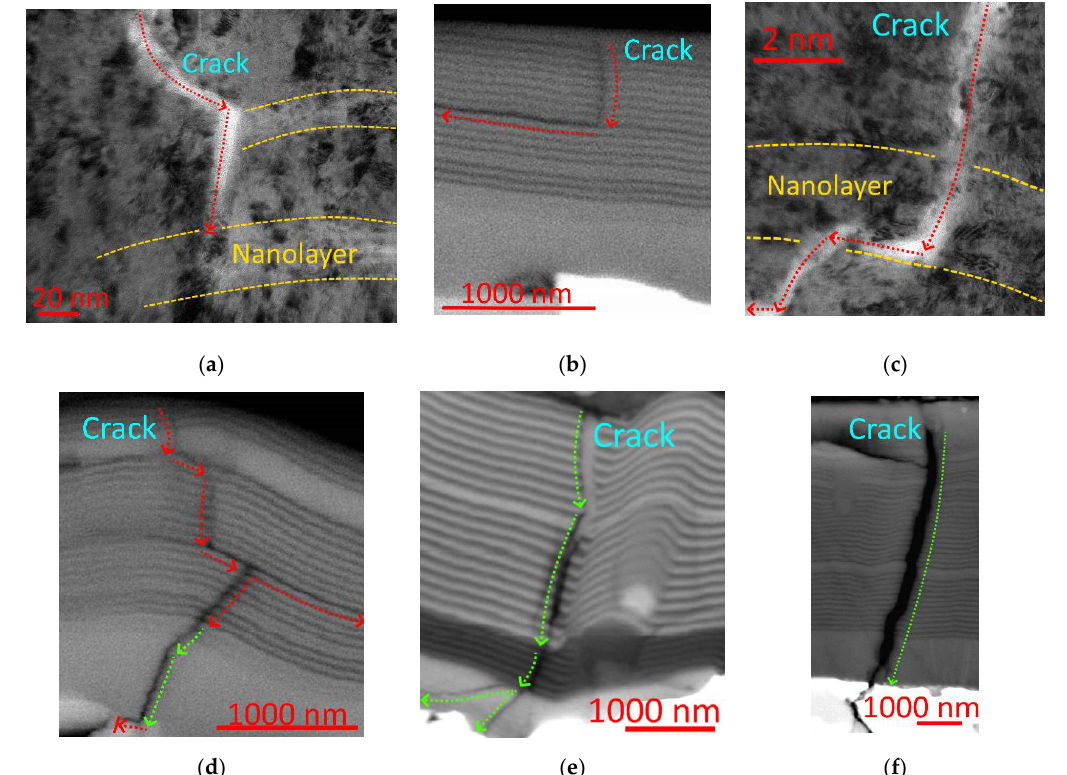
Figure 5. Examples of the crack propagation in the multilayer coating Ti-TiN-(Ti,Cr,Al)N ( b , d – f ) and Zr,Nb-(Zr,Nb)N- (Zr,Nb,Al)N ( a , c ): ( a )—deceleration of the crack development in the nanolayer structure (transmission electron microscope (TEM)), ( b )—transformation of the crack into delamination (scanning electron microscope (SEM)), ( c )—deceleration of the crack development due to transformation into delamination between nanolayers (TEM), ( d )—complex development of the crack with partial transformation into delamination (SEM), ( e )—penetration by the crack through the coating structure with a slight deviation at the nanolayer interface (SEM), and ( f )—penetration by the crack through the coating as a whole, with no noticeable influence of the nanolayer structure (SEM). The arrows indicate the direction of crack development.